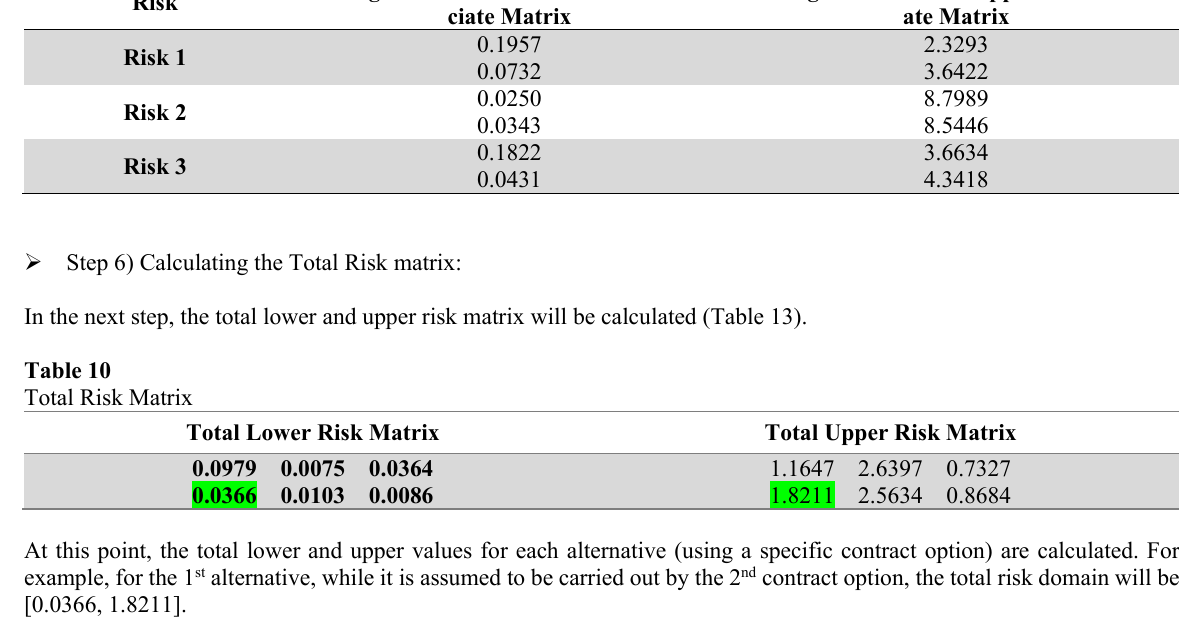
Averaged Normalized Risk Factor Risk